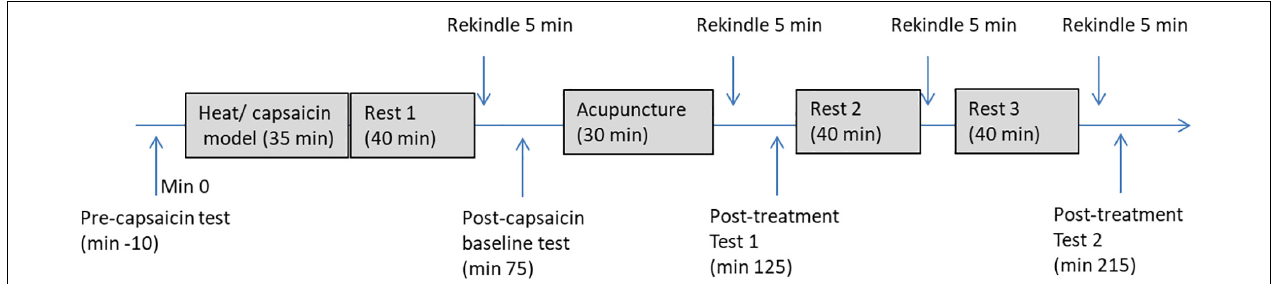
FIGURE 3 | A flow chart of the experiment procedure. Pre-capsaicin test includes HPT, rating to long-thermal stimulation; Post-capsaicin test, post-treatment test 1, and post-treatment test 2 includes HPT, rating to long-thermal stimulation and area of mechanical hyperalgesia.